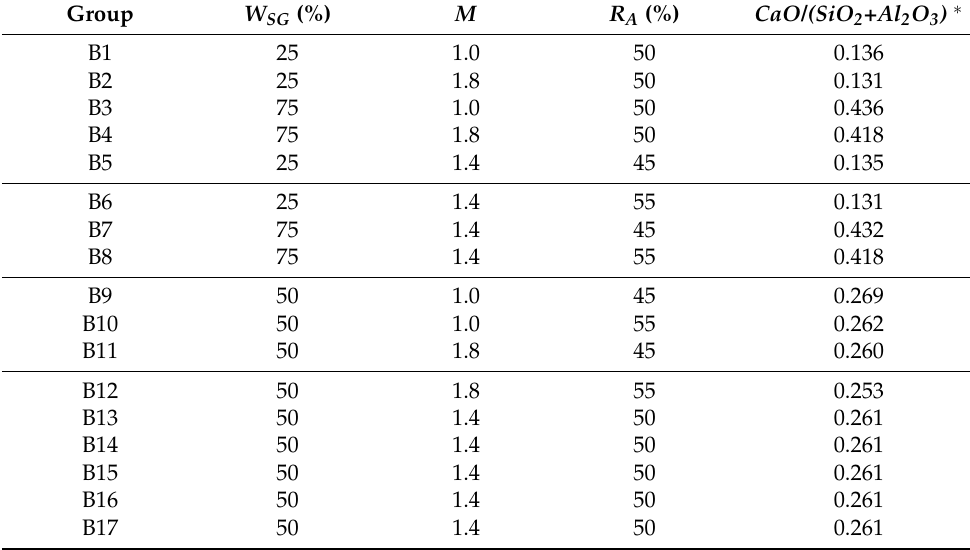
Table 3. Design scheme of response surface analysis under seal-curing